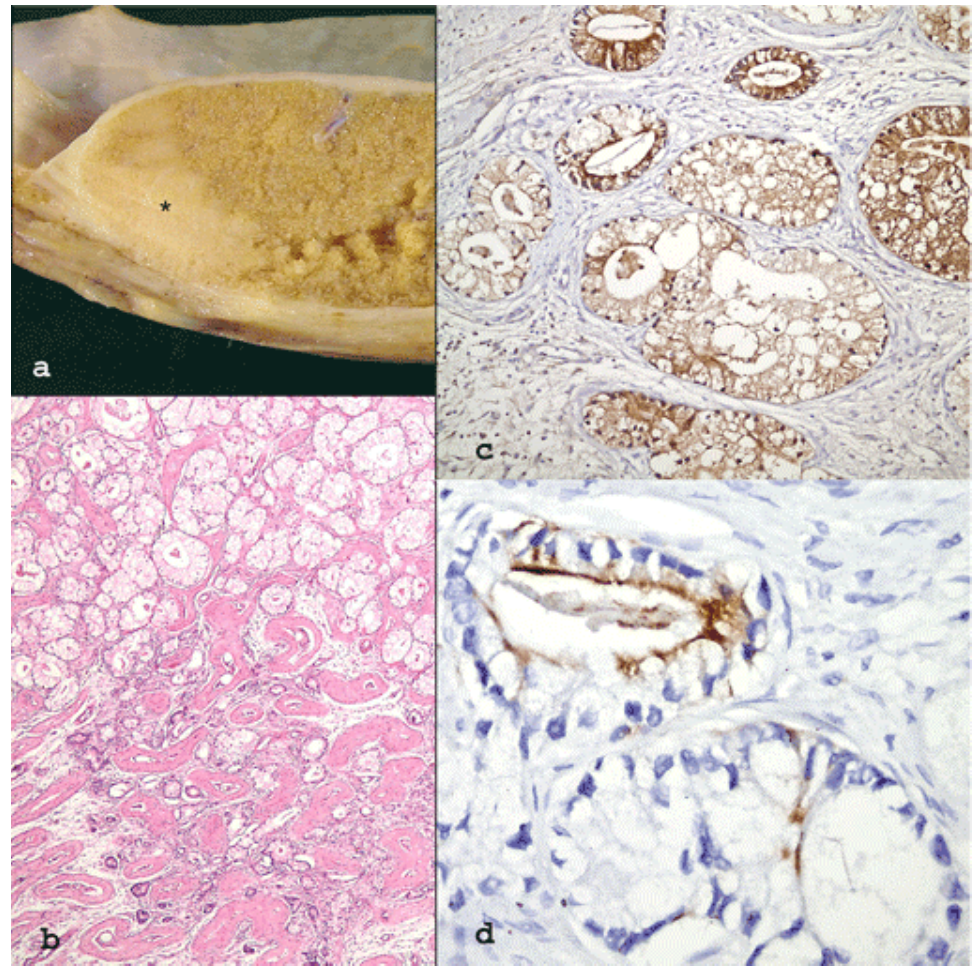
FIGURE 2. (a) Metastatic tumor in testis appears as irregular white focus, indicated by *; (b) neoplastic glands with foamy cytoplasm infiltrate between seminiferous tubules (H-E × 40); (c and d) they are positive diffusely for PSAP, focally for PSA (c: immunohistochemistry, anti- PSAP Ab × 200; d: immunohistochemistry, anti-PSA Ab ×